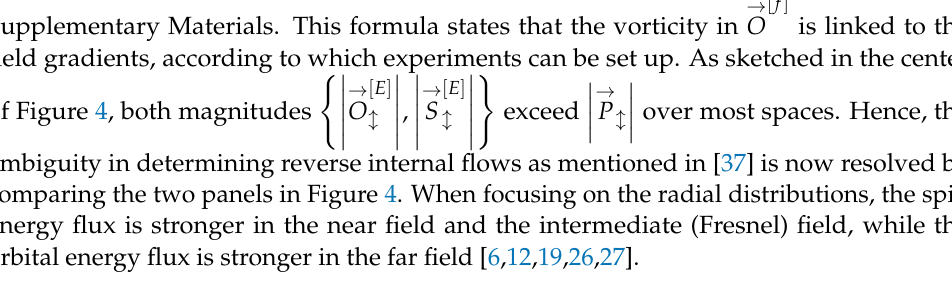
Figure 4. The streamlines formed by the internal flows over any meridional z ρ -plane for a linear dipole: ( a ) the orbital energy flux